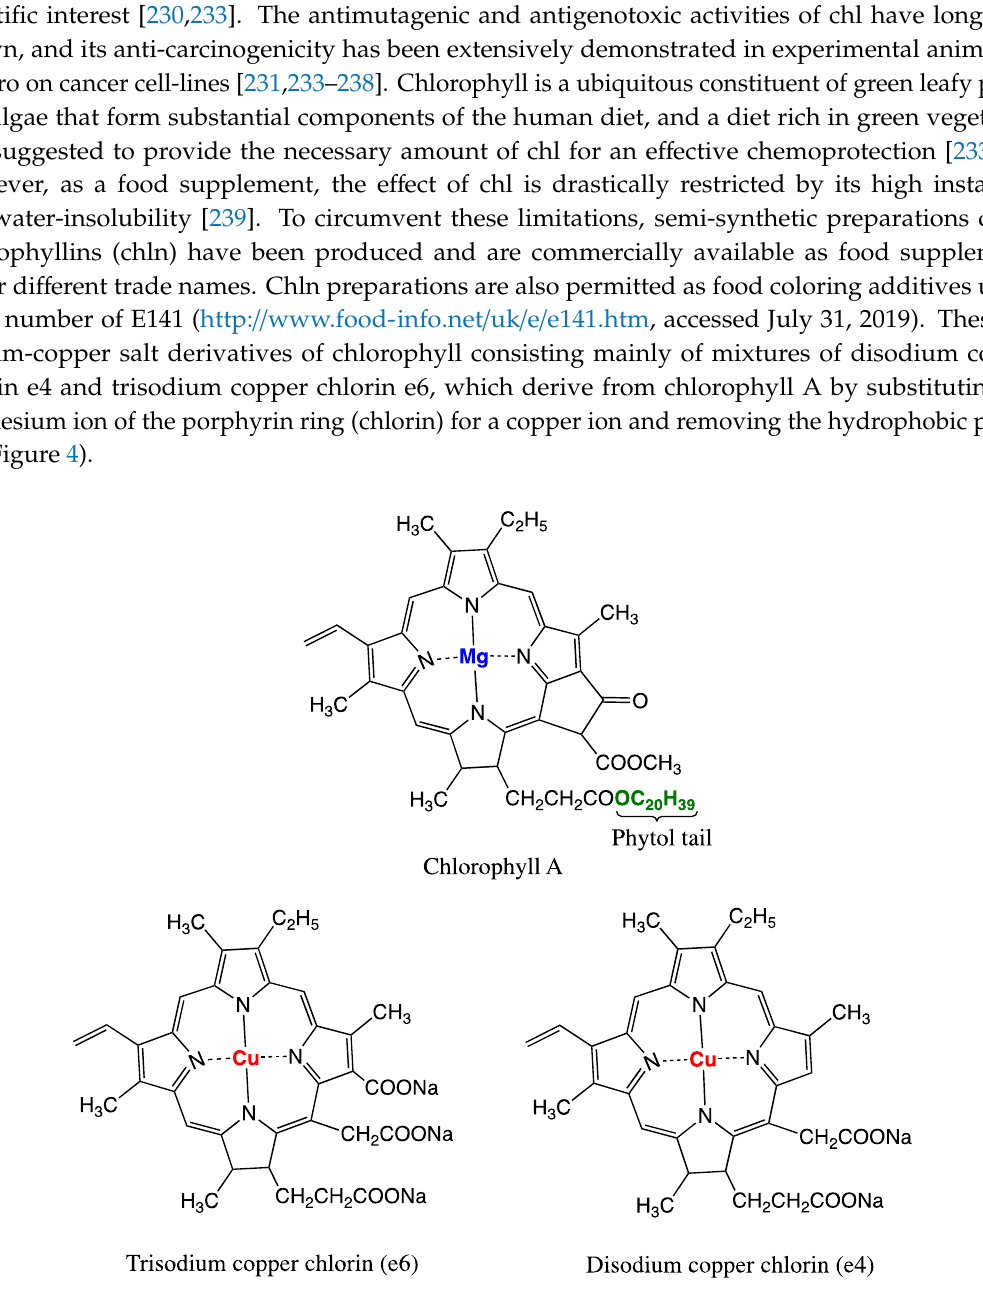
Figure 4. Chlorophyll A molecule naturally found in green plants, algae, and photosynthetic bacteria, and the two main semi-synthetic derivatives, disodium copper chlorin e4 and trisodium copper chlorin e6, commonly used in commercial chlorophyllin food supplements.